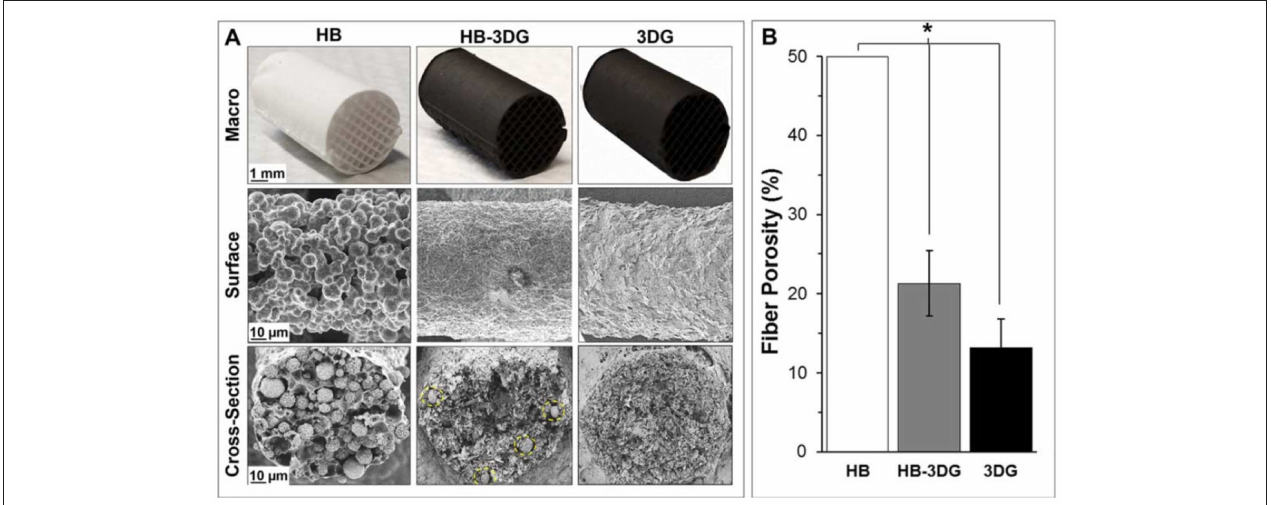
FIGURE 6 | (A) Digital images of HB, 3DG, and HB − 3DG and their corresponding SEM images of the fiber surfaces along with cross-sections. Yellow-dotted circle lines represent hydroxyapatite (HAp) particles within the graphene matrix in HB − 3DG. (B) Porosity (%) within HB, 3DG, and HB − 3DG-printed fibers (* p < 0.05, error bar represents standard deviation). Reproduced from Jakus and Shah (2017) with permission from Wiley Periodicals,